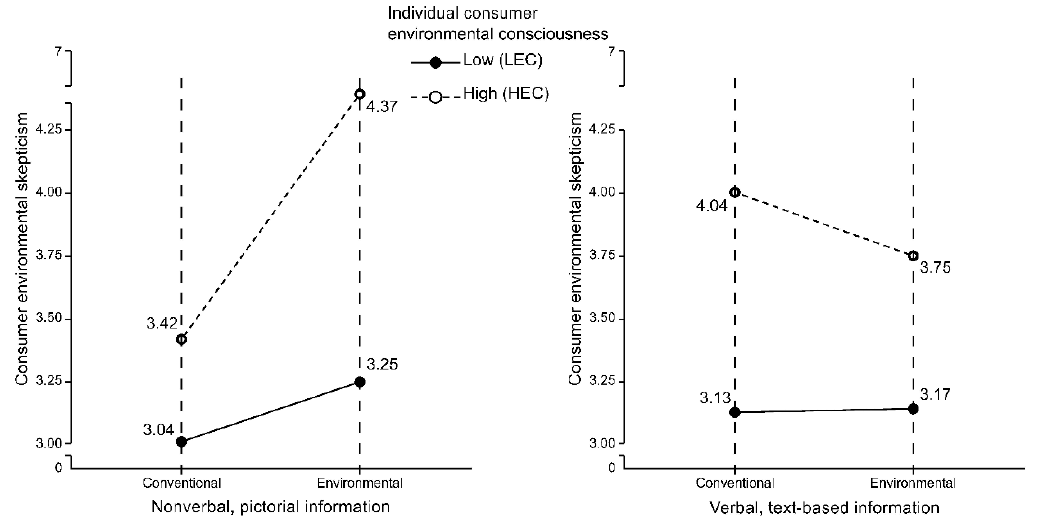
Figure 4. Effect of nonverbal, pictorial ( left ) and verbal, text-based ( right ) information and environmental consciousness on consumer environmental skepticism.